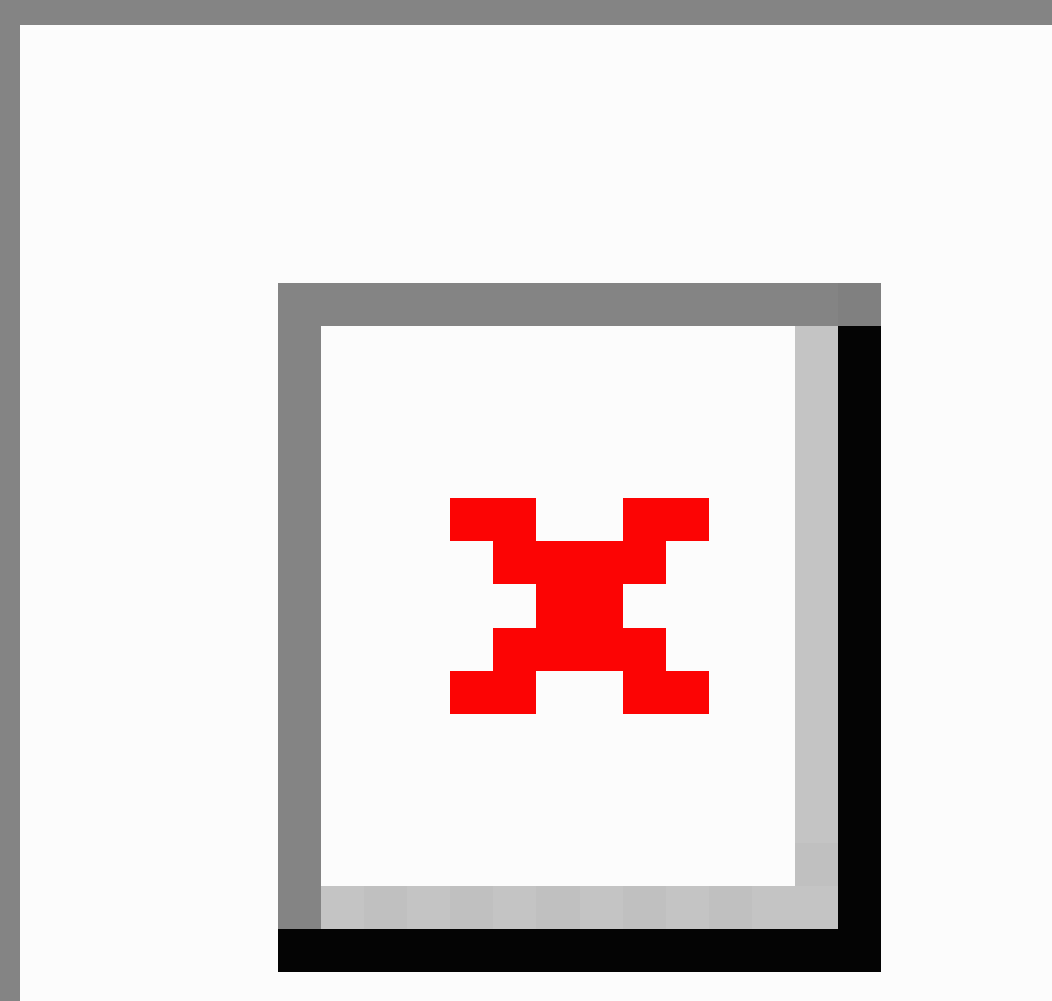
Figure 1. Illustration of the interaction for an mHealth app with the proposed cooperation approach for 4